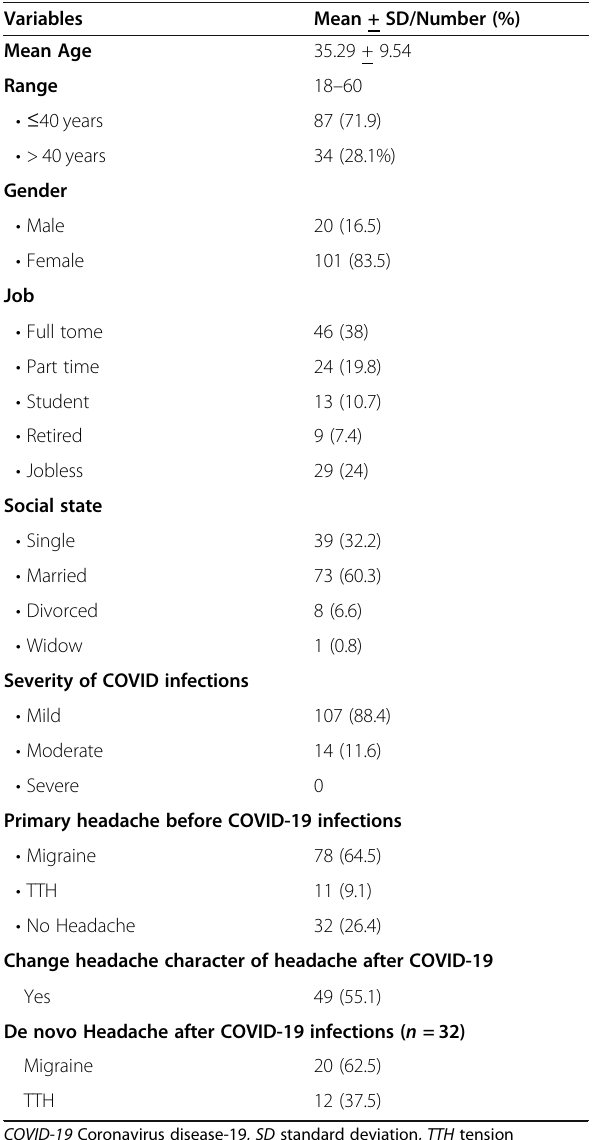
Table 1 Characteristics of headaches patients with